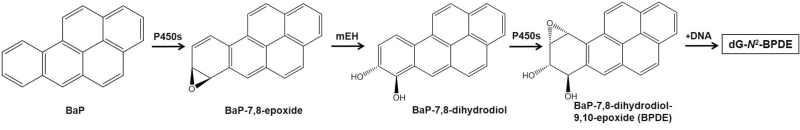
P450-mediated bioactivation pathway of BaP.